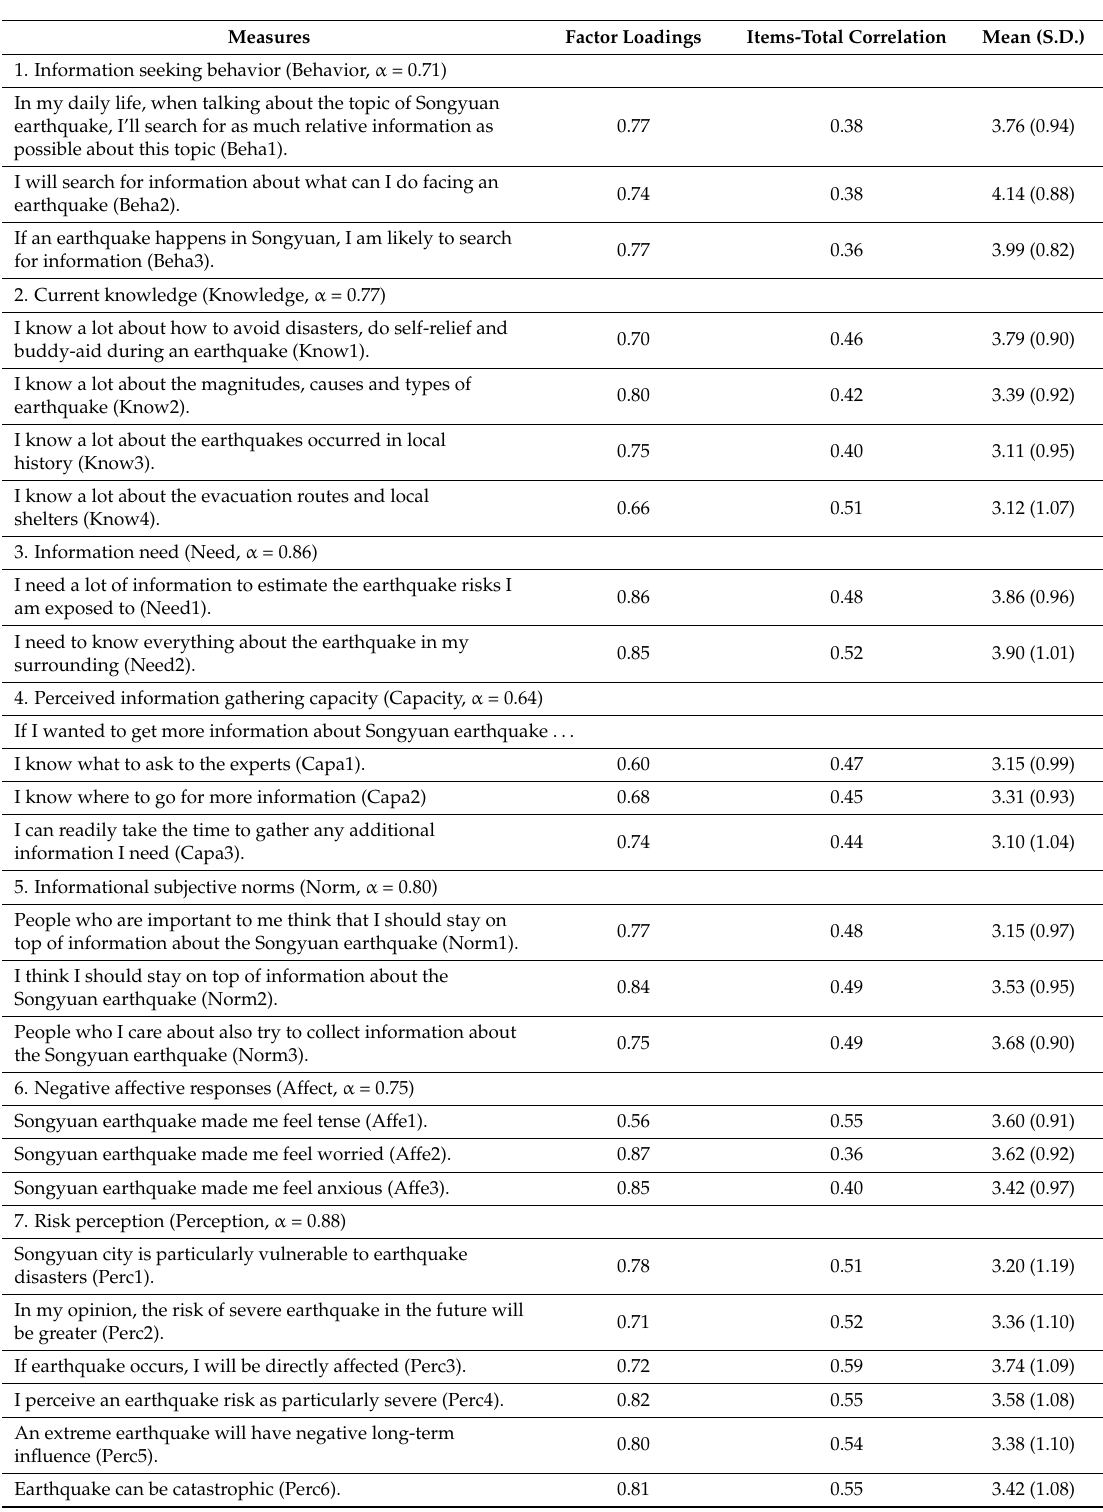
Table 1. Overview of exploratory factor analysis and reliability analysis. Measures Factor Loadings Items-Total Correlation Mean